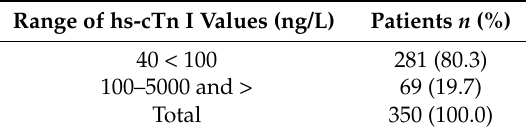
Table 3. Values of hs-cTn I in patients with positive hs-cTn I test